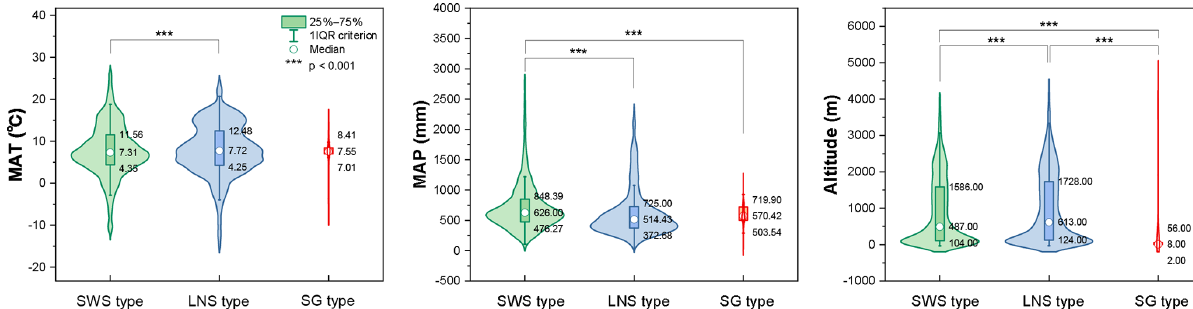
Figure 22. Violin diagrams of three pollen types from Artemisia , showing the variations (25%–75%) in MAT, MAP, and altitude. Asterisks indicate statistically significant differences ( p < 0 . 001).